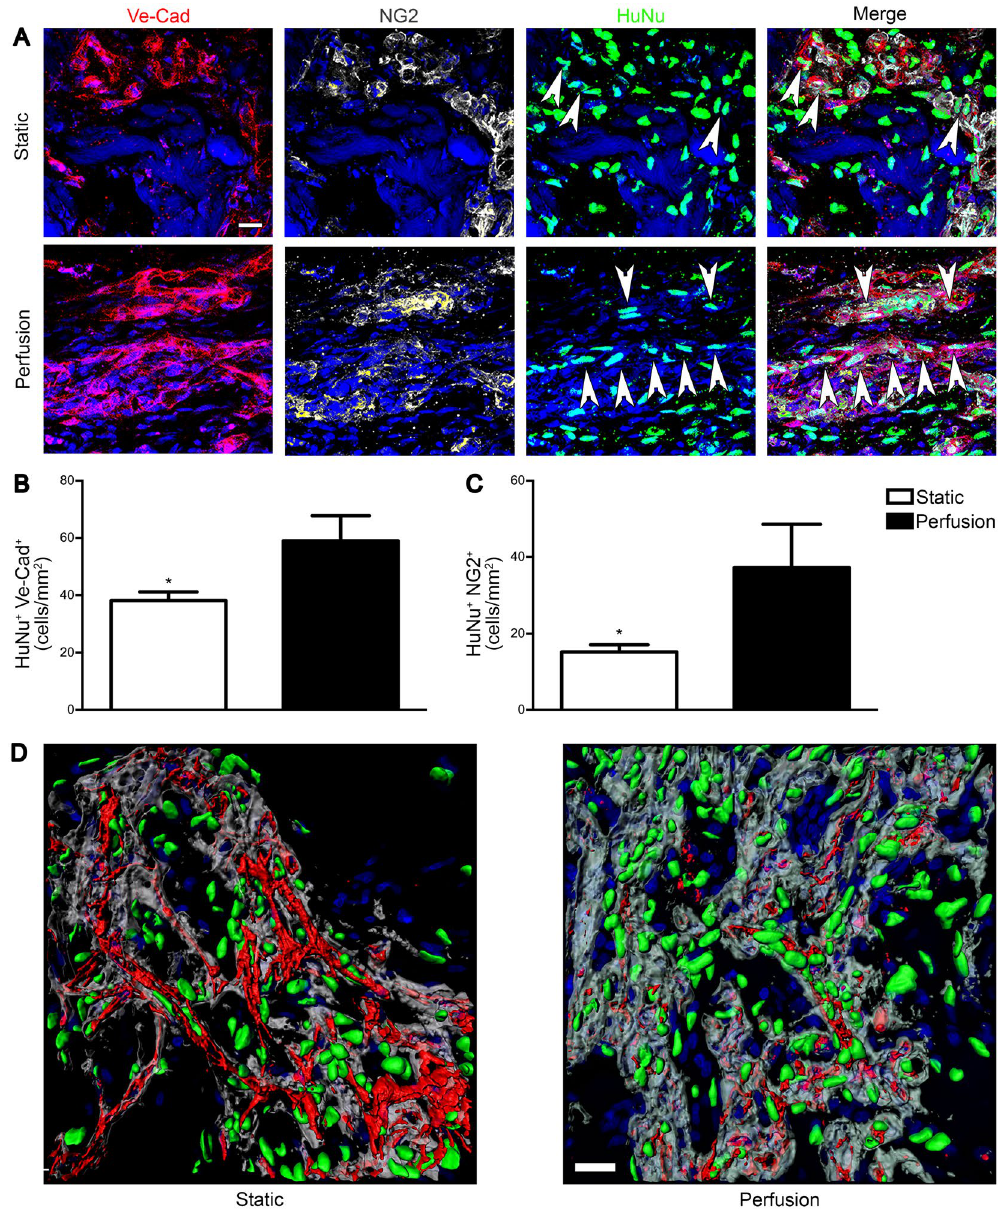
Figure 5. Perfusion-cultured human cells were directly involved in the formation of blood vessels. Patches were analysed after 28 days in vivo . ( A ) Representative immunofluorescence images of EC (Ve-Cad; red), pericytes (NG2; grey) and HuNu (green). White arrows indicate human cells directly involved in the formation of blood vessel Ve-Cad + or NG2 + . Quantification of the human cells Ve-Cad + ( B ) and NG2 + ( C ) normalized over the analyzed area (n donor = 3). ( D ) 3D reconstruction of immunofluorescence images of EC (Ve-Cad; red), basal lamina (Laminin; grey) and HuNu (green). Nuclei were stained with DAPI (blue in A , D ). * p < 0.05. Scale bar = 20 μ